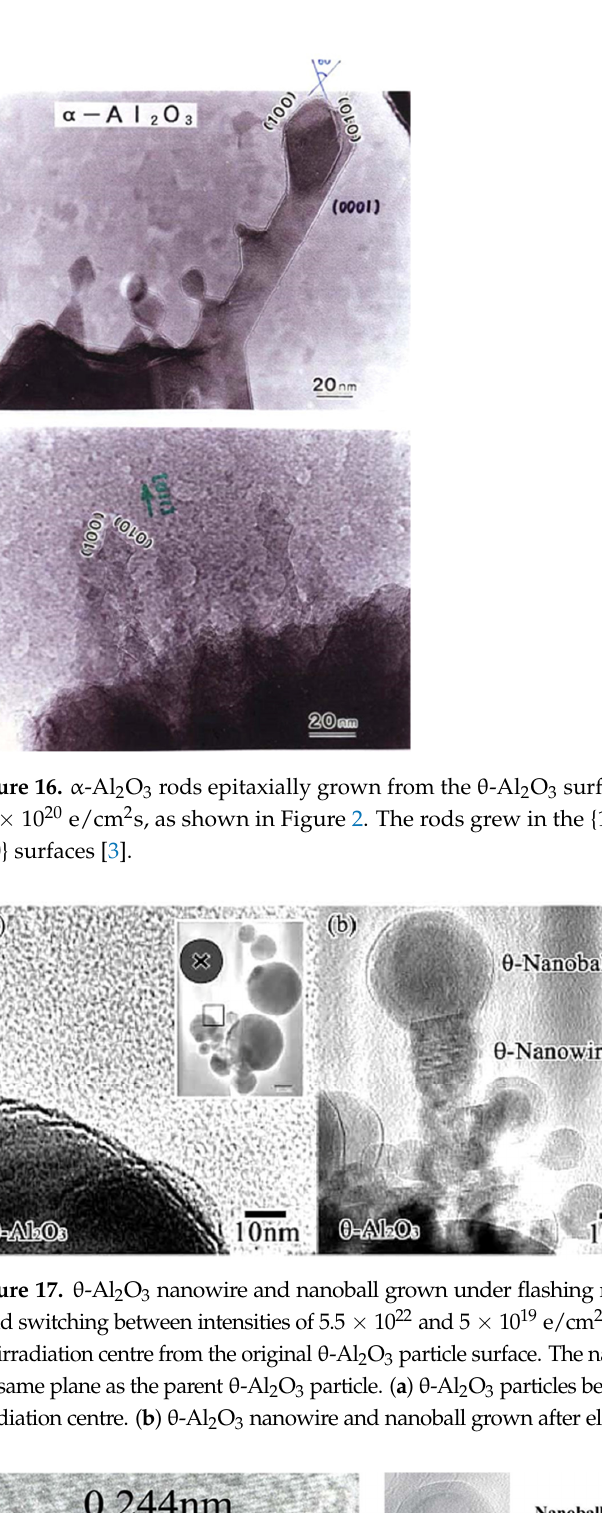
Figure 19. -Al 2 O 3 nanowire and nanoball grown under flashing mode electron beam irradiation with intensities switching between 5.5 × 10 22 and 5 × 10 19 e/cm 2 sec. They connected and grew toward the irradiation centre from the original -Al 2 O 3 particle surface. ( a ) -Al 2 O 3 particles before irradiation, with X indicating the irradiation centre. ( b ) -Al 2 O 3 nanowire and nanoball grown after electron beam irradiation [13].